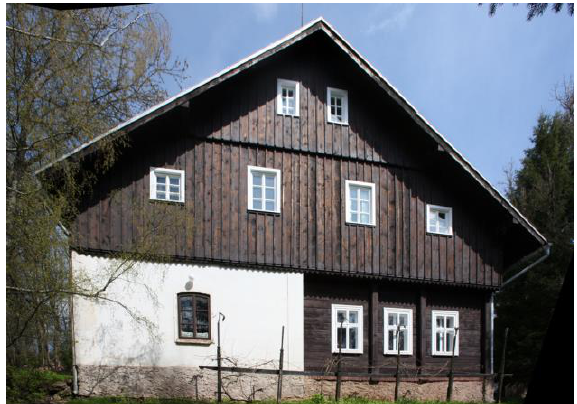
Figure 3. Example of an examined building, Rudník – Bokov (Trutnov dist.)